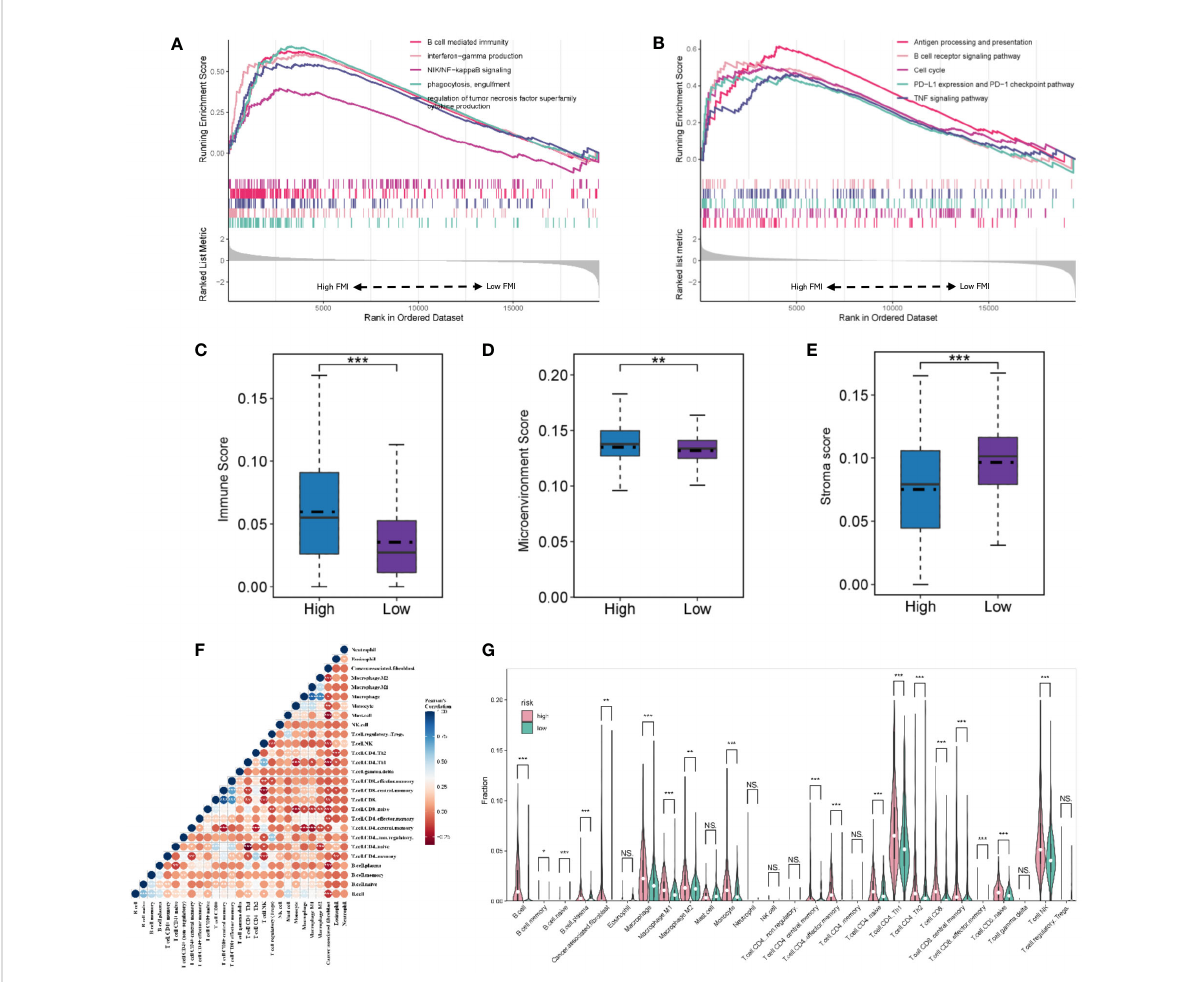
FIGURE 6 Gene set enrichment analysis and landscape of the immune microenvironment in the TGCA-KIRC. GO (A) and KEGG pathway (B) analyses of the high- and low-FMI groups. (C, D, E) Evaluation of the tumor microenvironment of ccRCC. (F) The correlation of in fi ltrating immune cells. (G) Violin diagram of the proportions of different tumor-in fi ltrating cells in the high- and low-FMI group. * P < 0.05; ** P < 0.01; *** P < 0.001. ns means no signi fi